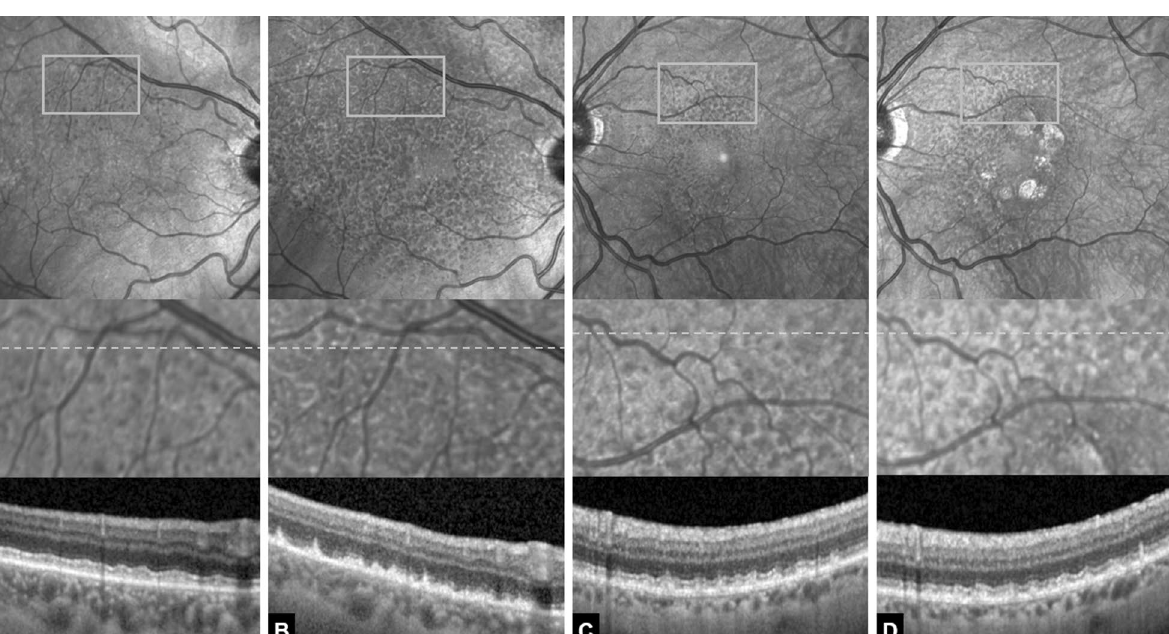
Table 2. Choriocapillaris parameters at baseline and follow-up. a Significantly different at baseline. b Significantly different from baseline by two-way repeated measures ANOVA (time effect). c Significant between-group difference by two-way repeated measures ANOVA (interaction effect). Data are mean ± SD. Data were tested for normal distribution using Kolmogorov–Smirnov test. CC choriocapillaris, SD standard deviation, RPD reticular pseudodrusen.